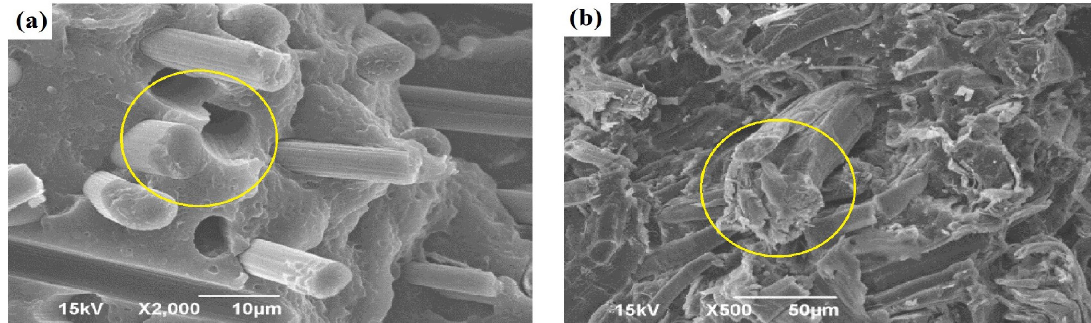
Figure 5. SEM of fractured surface of SF